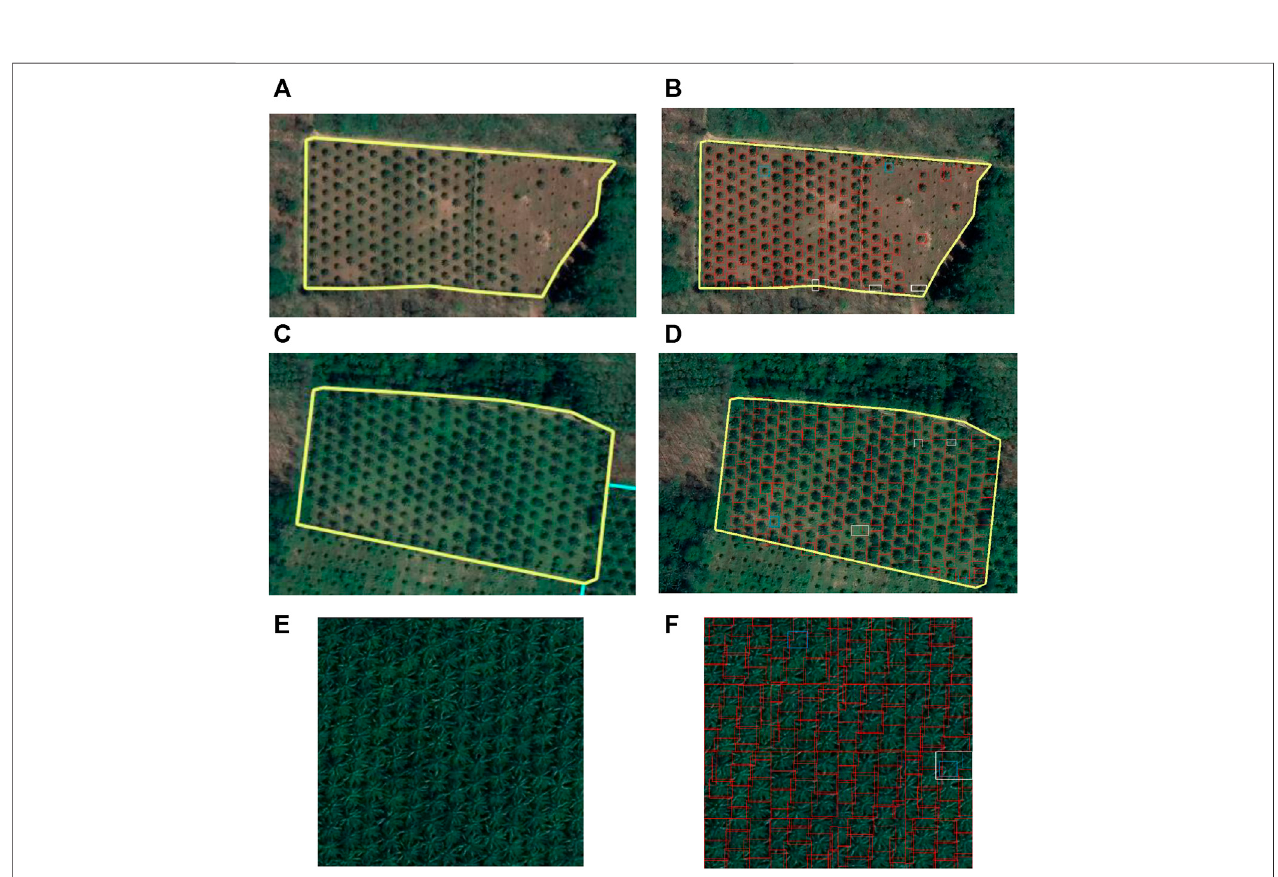
FIGURE 7 | Results of different methods in palm: (A) original image of sample site 1, (B) YOLOv4-Lite of sample site 1, (C) original image of sample site 2, (D) YOLOv4-Lite of sample site 2, (E) original image of sample site 3, and (F) YOLOv4-Lite of sample site 3.